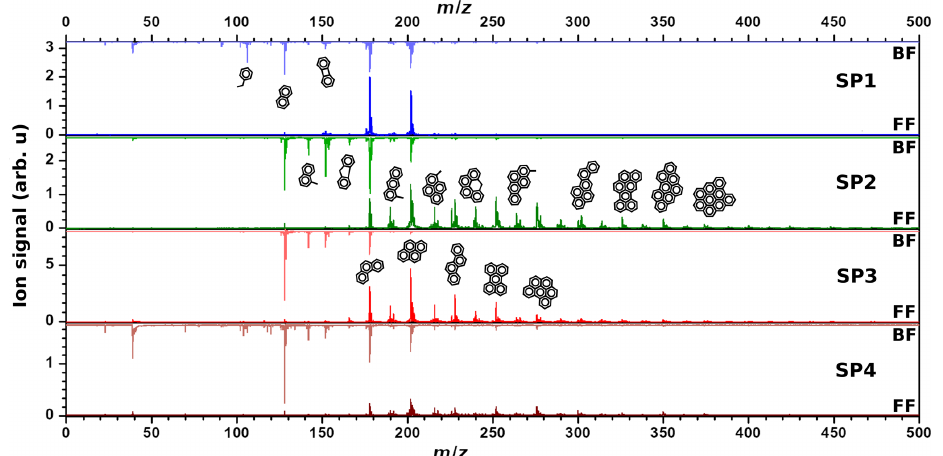
Figure 2. Comparison between mass spectra for SP1, SP2, SP3, and SP4 samples recorded with λ i = 266nm for front filters (lower spectra) and back filters (upper spectra). Note that four different areas have been averaged to yield each of these spectra. Proposed structural formulae based on molecular formulae obtained from mass spectra are also shown.